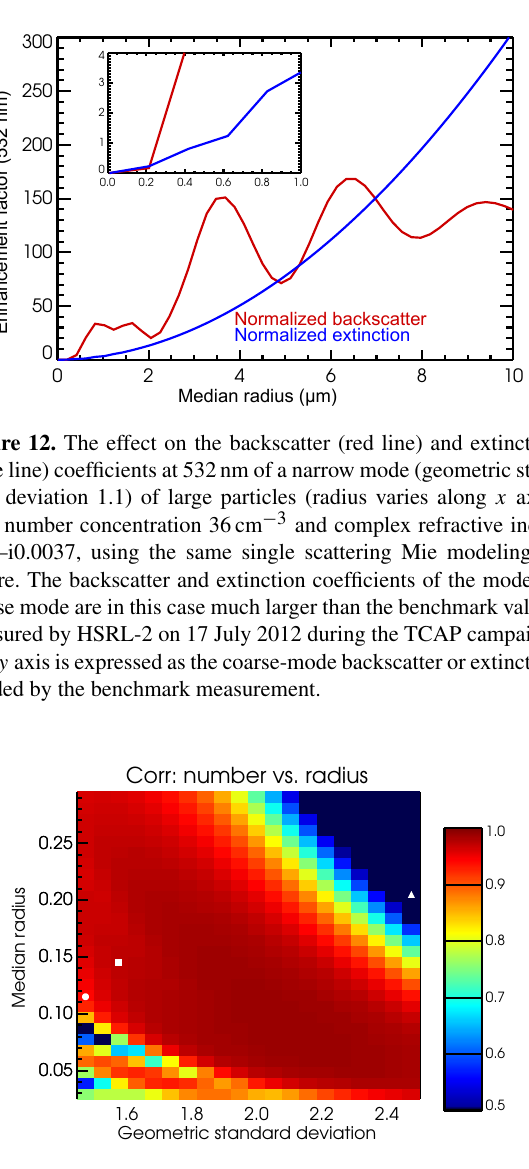
Figure 13. The a posteriori correlation between retrieved total num- ber concentration and median radius is here, as a function of median radius and geometric standard deviation, with the complex refrac- tive index held fixed at 1.470–0.00325i and the total number con- centration held fixed at 1001cm − 3 . Similar to Fig. 5, but here num- ber concentration is replaced by volume concentration as one of the five independent state variables. Significant differences compared to Fig. 5 can be seen for large effective radii, the upper right quadrant of the figure. Symbols are as in Fig. 5.